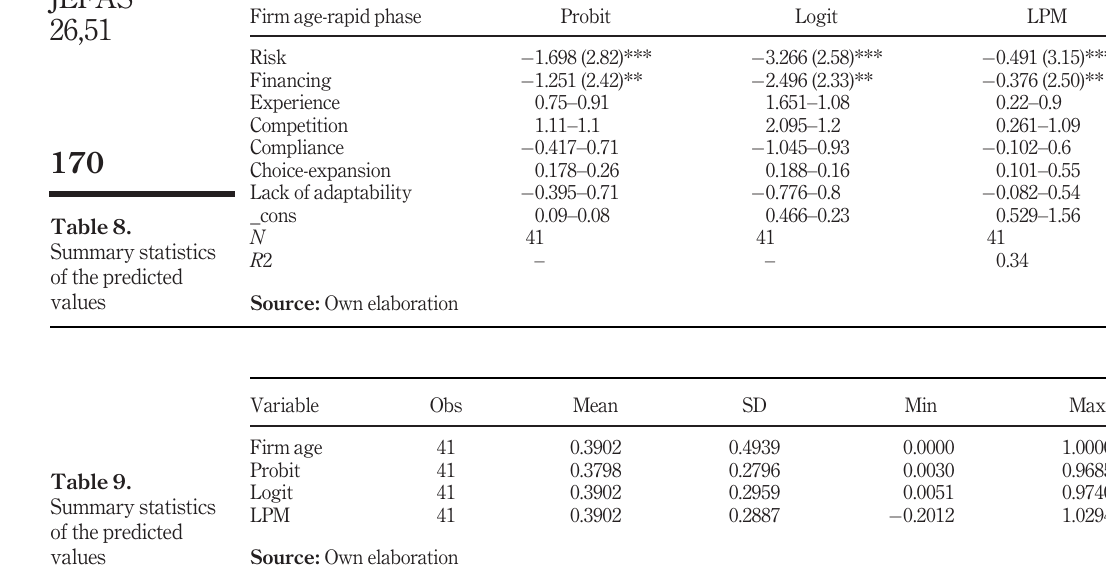
Table 9. Summary statistics of the predicted values